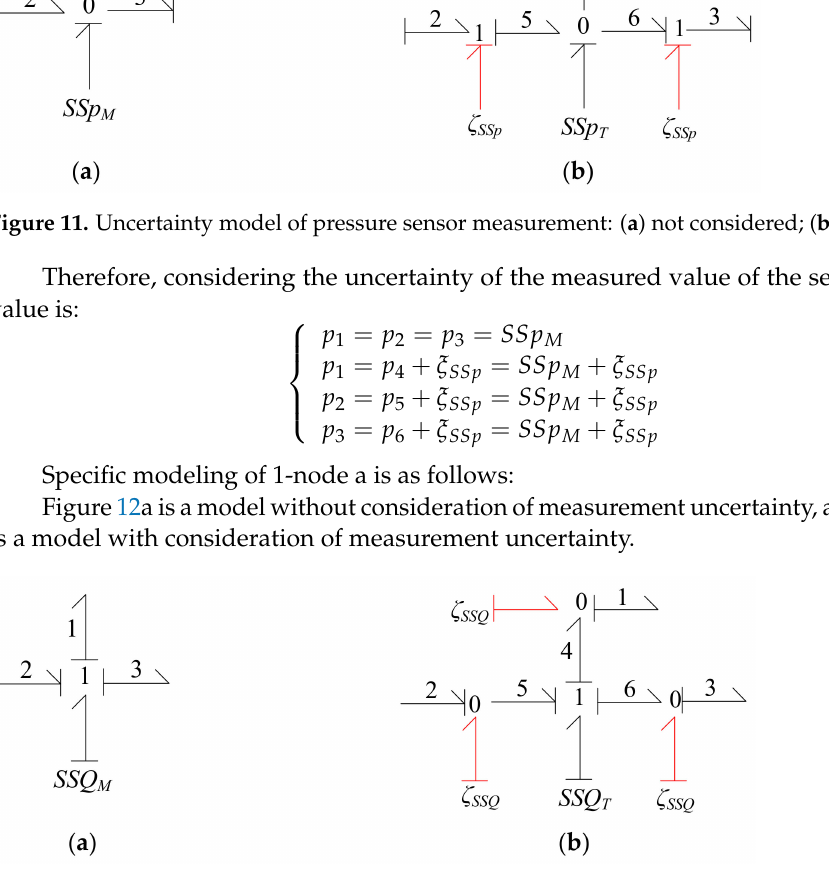
Figure 12. Uncertainty model of flow sensor measurement: ( a ) not considered; ( b )